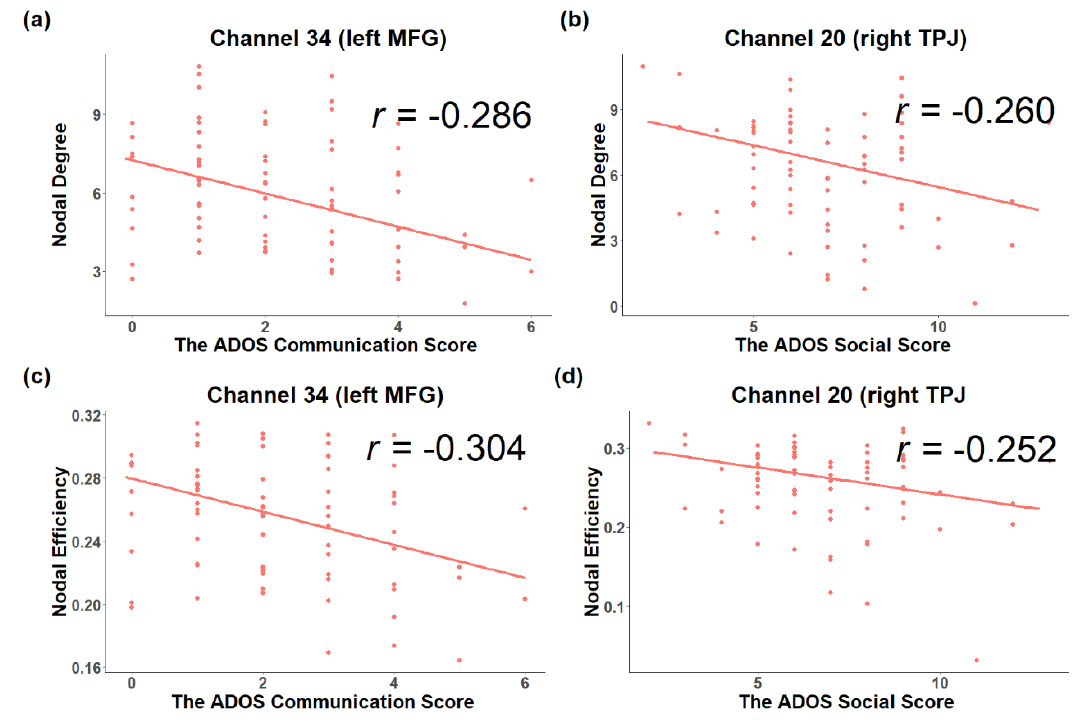
Figure 5. The partial correlation coefficients between nodal metrics and ADOS scores after controlling the effect of age. The nodal degree ( a ) and nodal efficiency ( c ) of the channel 34 in the left MFG showed a negative association with ADOS communication scores, while nodal degree ( b ) and nodal efficiency ( d ) of channel 41 in the left STG showed a negative association with ADOS social scores.